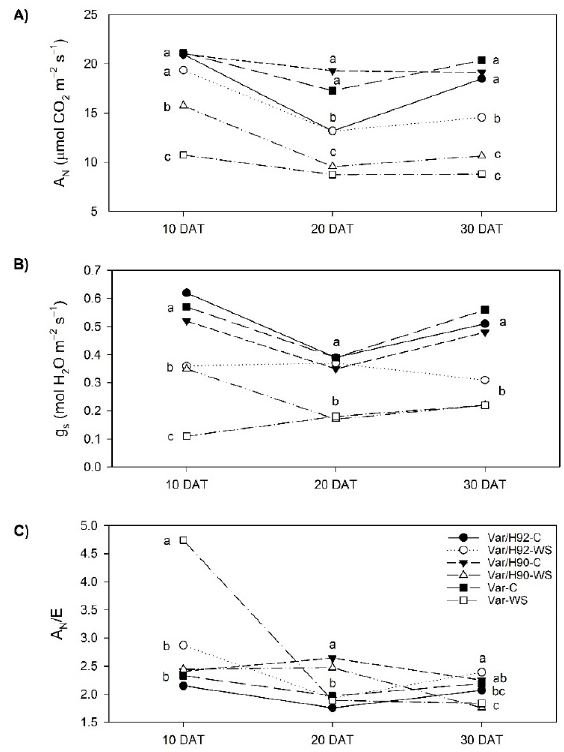
Figure 2. ( A ) CO 2 assimilation rate (A N , µ mol CO 2 m − 2 s − 1 ), ( B ) stomatal conductance to water vapor (g s , mol H 2 O m − 2 s − 1 ), and ( C ) instantaneous water use efficiency (A N /E) in the ungrafted plants (Var, variety “Sueca”) and Var grafted onto H92 or H90 (Var/H92 and Var/H90, respectively) under the water stress (WS) or control conditions (C). Measurements were taken at 10, 20, and 30 DAT (days after treatment). Data are the mean value for n = 4 for each plant type and treatment combination. Different letters indicate significant differences at p < 0.05 (LSD test) for each measurement time separately.